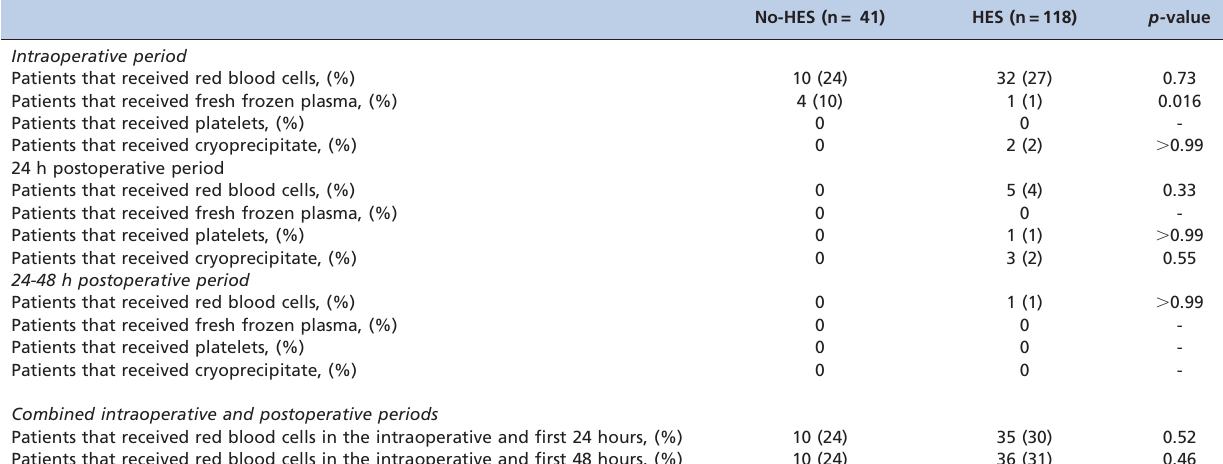
corresponding 95% confidence intervals for each variable were computed. The discriminative ability of the model to predict the outcome of patients was assessed by the area under the receiver operating characteristic (AUC)